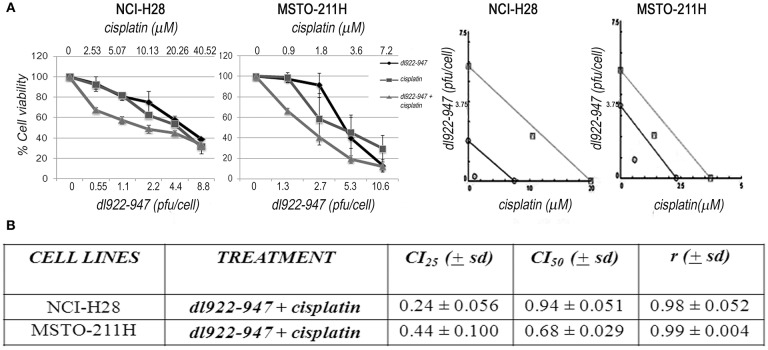
Synergistic effect of the dl922-947 and cisplatin combination. (A) MSTO-211H and NCI-H28 cell viability was analyzed by SRB assay 5 days after treatment with dl922-947, both alone and in combination with cisplatin. Left: Dose—response curves for dl922-947 alone, cisplatin alone and their combination. Results represent the means and standard deviations of two independent experiments, each conducted in triplicate, and are expressed as percentages of cell viability, calculated with respect to the control cells treated with DMSO alone. Right: Isobologram analysis to assess drug synergism. Isobolograms are derived from the mean values of the dose—response experiments reported in the left, through the CompuSyn software 1.0 at an effect level of 25 and 50%. Data points on the line indicate additivity; points below the line indicate synergy; points above the line indicate antagonism. (B) The table reports the means ± s.d. of the drug combination index (CI) at 25% (CI25) and 50% (CI50) of cell killing after 5 days of treatment and the r-values. CI values below 1 indicate drug synergism.